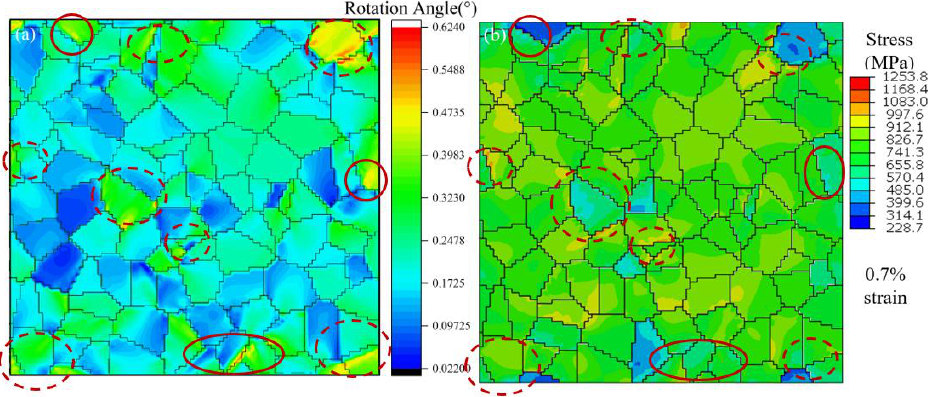
Figure 10. 0.7% strain: ( a ) the grain rotation angle distribution; and ( b ) the stress distribution.